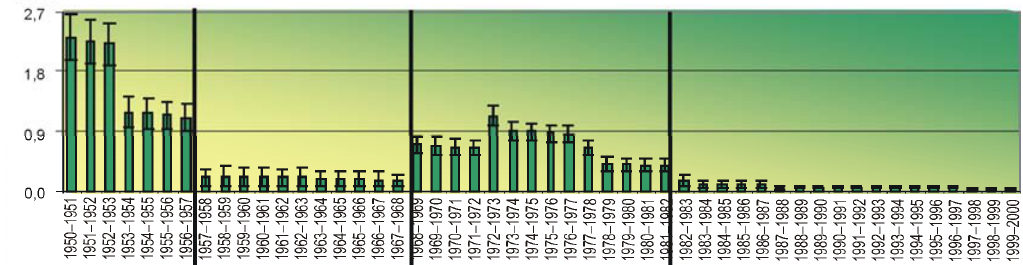
90 Fig. 2. Variation of Sr activity in tree ring wood at 1 m height from litter, considering radioactive